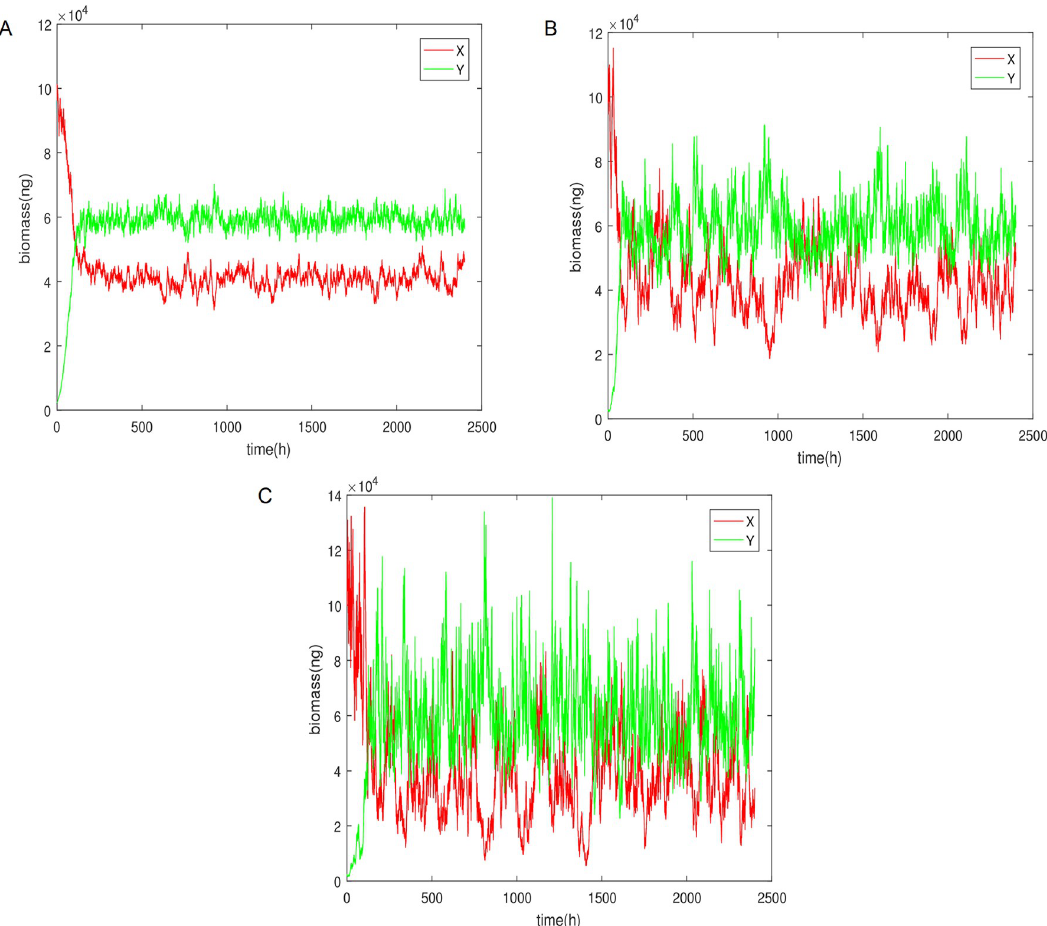
Fig 6. Stochastic simulation of the biomass of the the two populations, using the Euler-Maruyama method, for low, medium and high noise intensity values equal for both population in all simulations. (A) σ 1 = σ 2 = σ 3 = 0.02. (B) σ 1 = σ 2 = σ 3 = 0.05. (C) σ 1 = σ 2 = σ 3 =